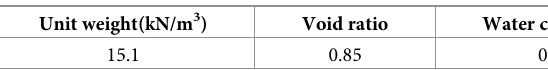
22]. Figs 5 and 6 show the soil strain nephogram of test sand with 300mm and 400mm filling height under different displacement states. The shear strain area is mainly concentrated at the top of the retaining wall cantilever in the initial stage. With the displacement increase the shear strain area gradually expands and develops downward, forming a sliding surface. are shown in Figs 7 and 8. The lower end of the sliding failure surface is close to the displace- ment zero-point passing through the middle of the wall body, and the upper end slides out of